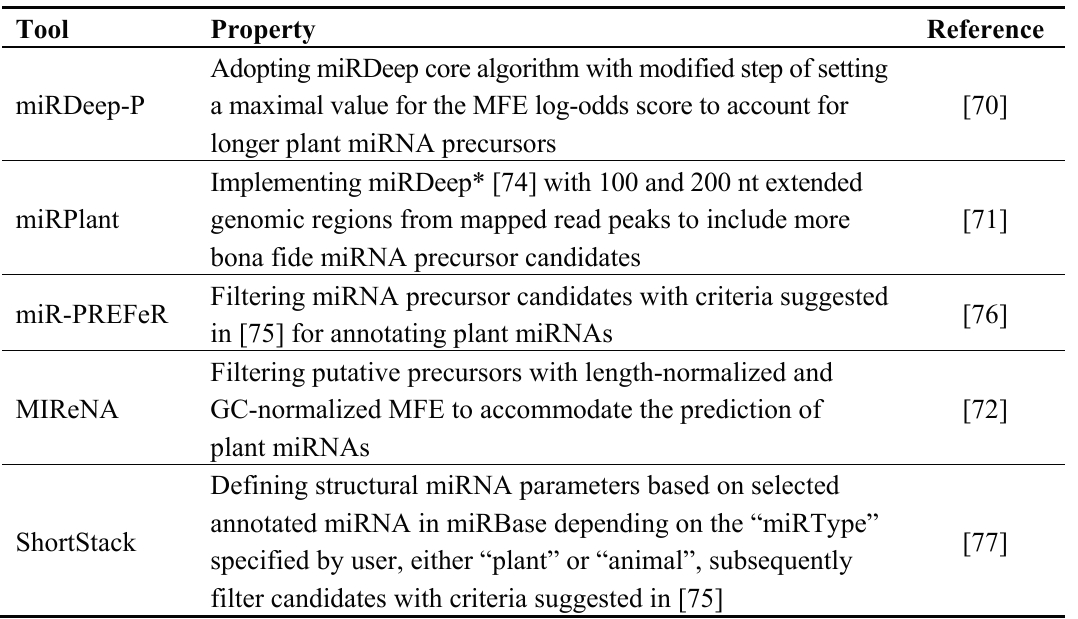
Table 3. Summary of plant-friendly miRNA prediction tools using deep sequencing data.